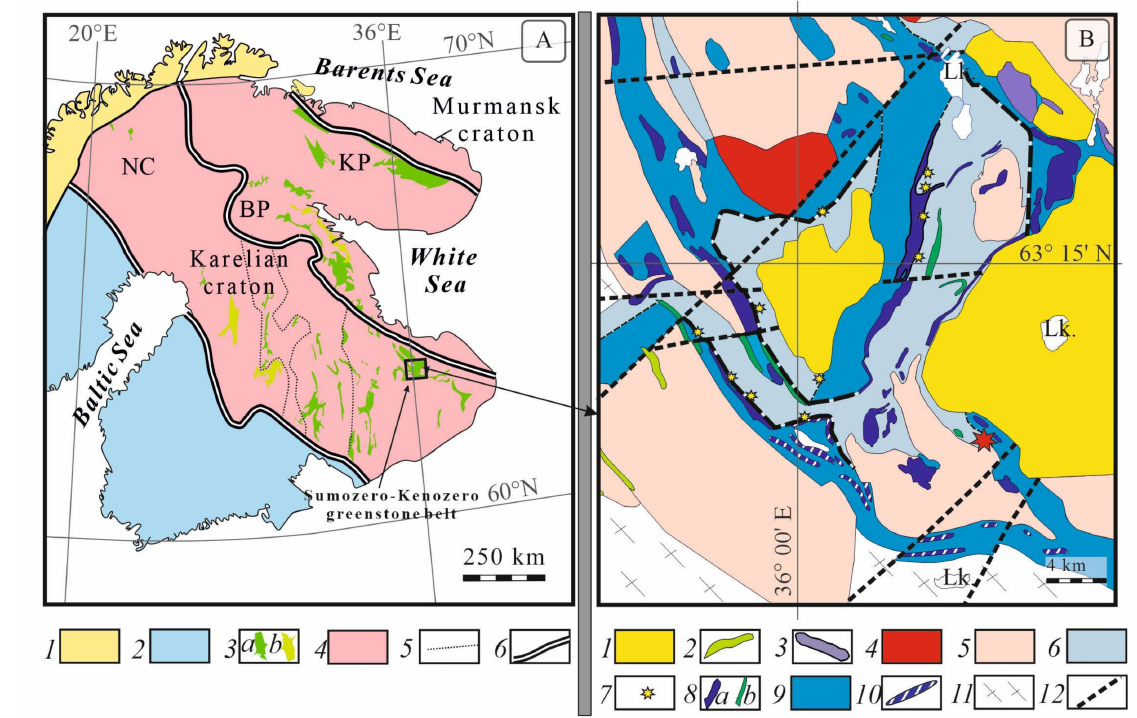
Figure 1. ( A ) Map showing the tectonic division of the Fennoscandian shield and the location of the Sumozero-Kenozero greenstone belt [35,36]. 1—Baikalids and Caledonides; 2—Paleoproterozoic juve- nile crust; 3—Archean greenstone ( A ) and paragneiss ( B ) complexes; 4—Archean crust; 5—The Kare- lian Craton subprovince boundaries; 6—boundaries of Paleoproterozoic orogens. Letter abbreviation: KP—Kola Province, BP—Belomorian Province; NC—Norrbotten Craton. ( B ) Geological sketch map of the Kamennoozero greenstone belt and locations of ore deposits indicated by stars. Red star indicates the location of the studied Leksa deposit [34,39–41]. 1–3—Paleoproterozoic (Sumian): 1—basaltic andesite; 2—gabbro; 3—ultrabasite; 4–10—Archean: 4—Neoarchean granite; 5—Archean diorite, granodiorite, and tonalite; 6—Mesoarchean BARD- and Adakitic-series sedimentary-volcanic rocks interlaying with interbedded pyrite; 7—pyritic ore occurrences; 8—Mesoarchean ( A ) ultramafite and ( B ) gabbro; 9—Mesoarchean tholeiitic basalt; 10—Mesoarchean komatiite; 11—Paleo-Mesoarchean TTG-gneiss;